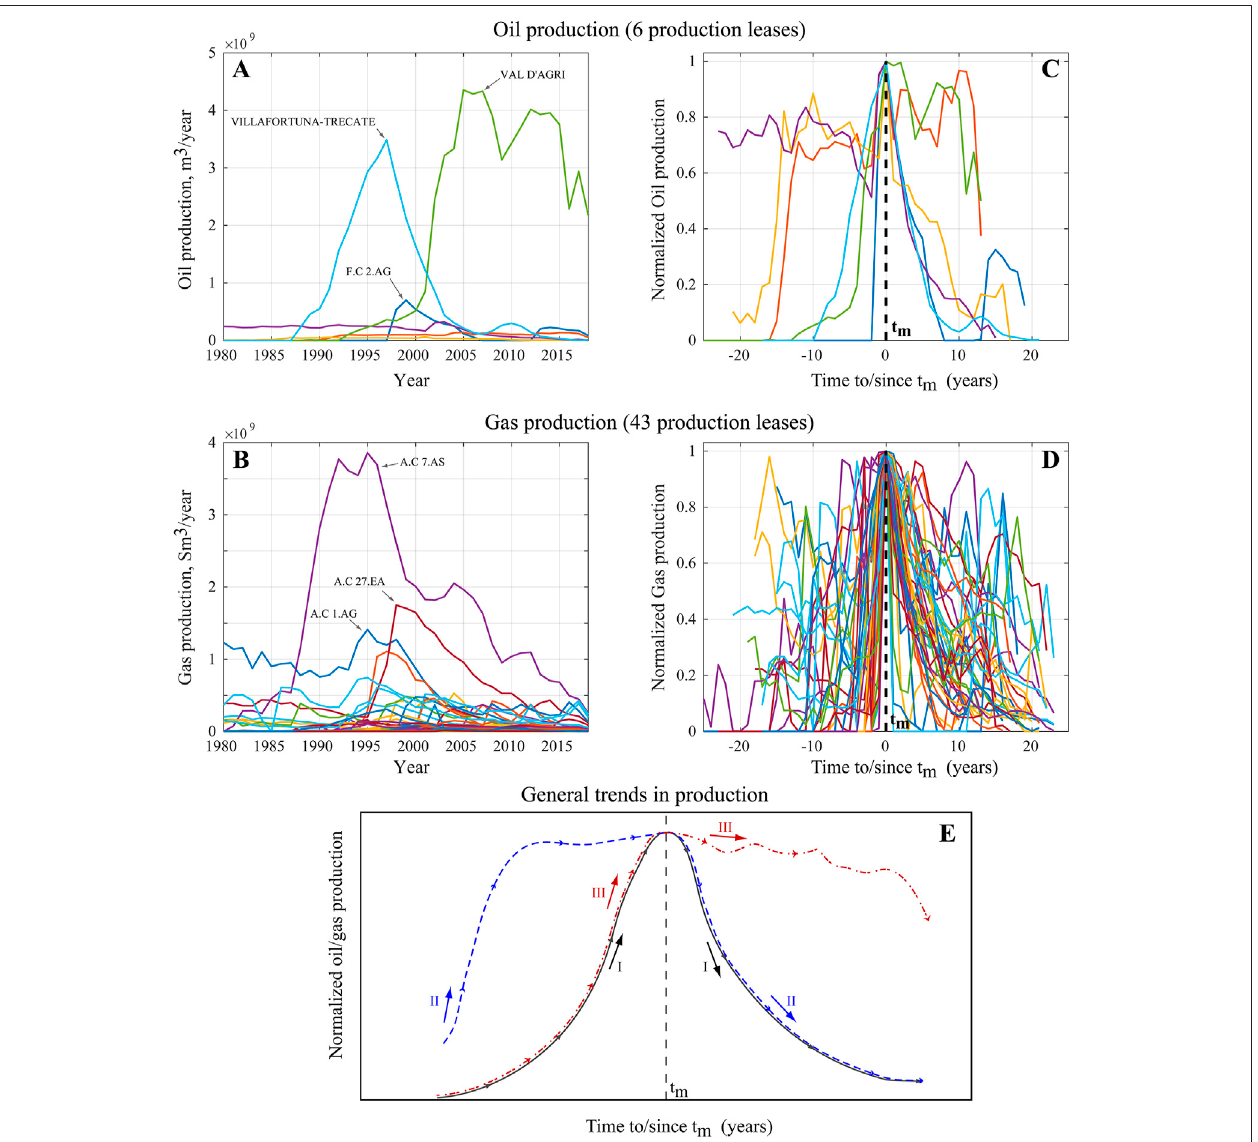
FIGURE 5 | Annual production of identi fi ed sites in which it is possible to perform the proposed analyses. Annual production of (A) oil and (B) gas in the selected developmentleases.Productiondatanormalizedbythemaximumvaluereachedineachtimeseriesandrealignedrespecttopeaktime, t m areshowninplots (C) (oil)and (D) (gas). (E) Main temporal trends observed in production data.